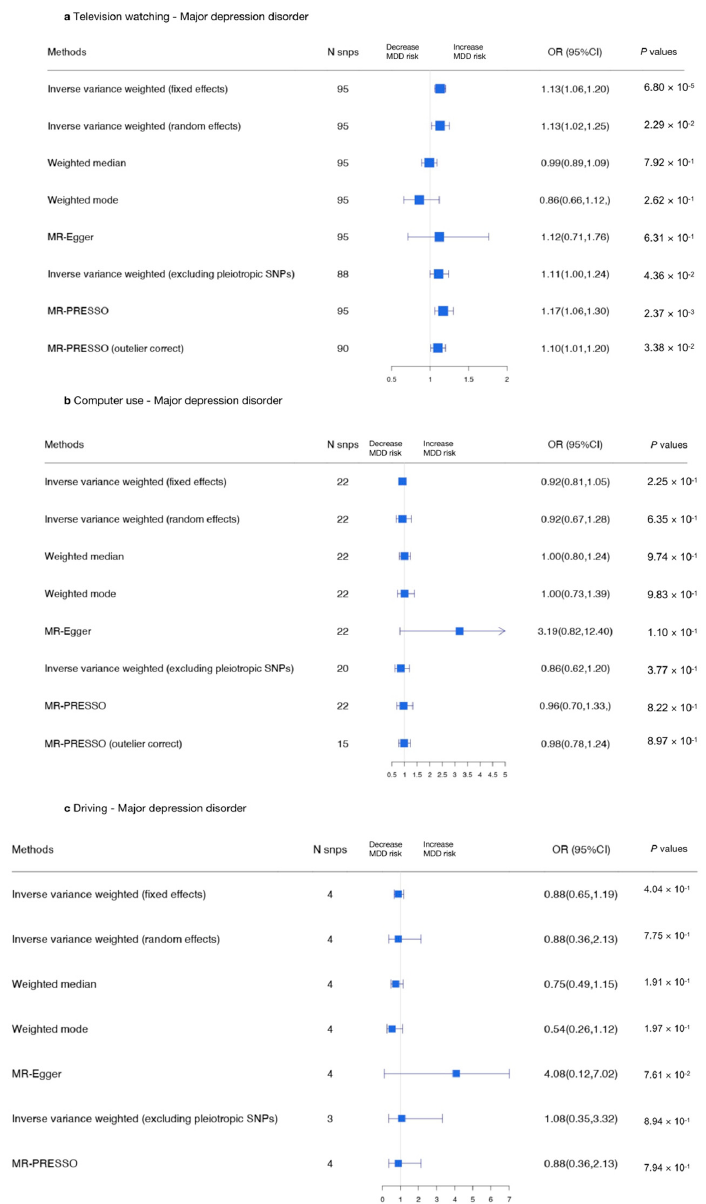
Figure 6 . Summarized Mendelian randomization (MR) effect sizes between sedentary behaviors